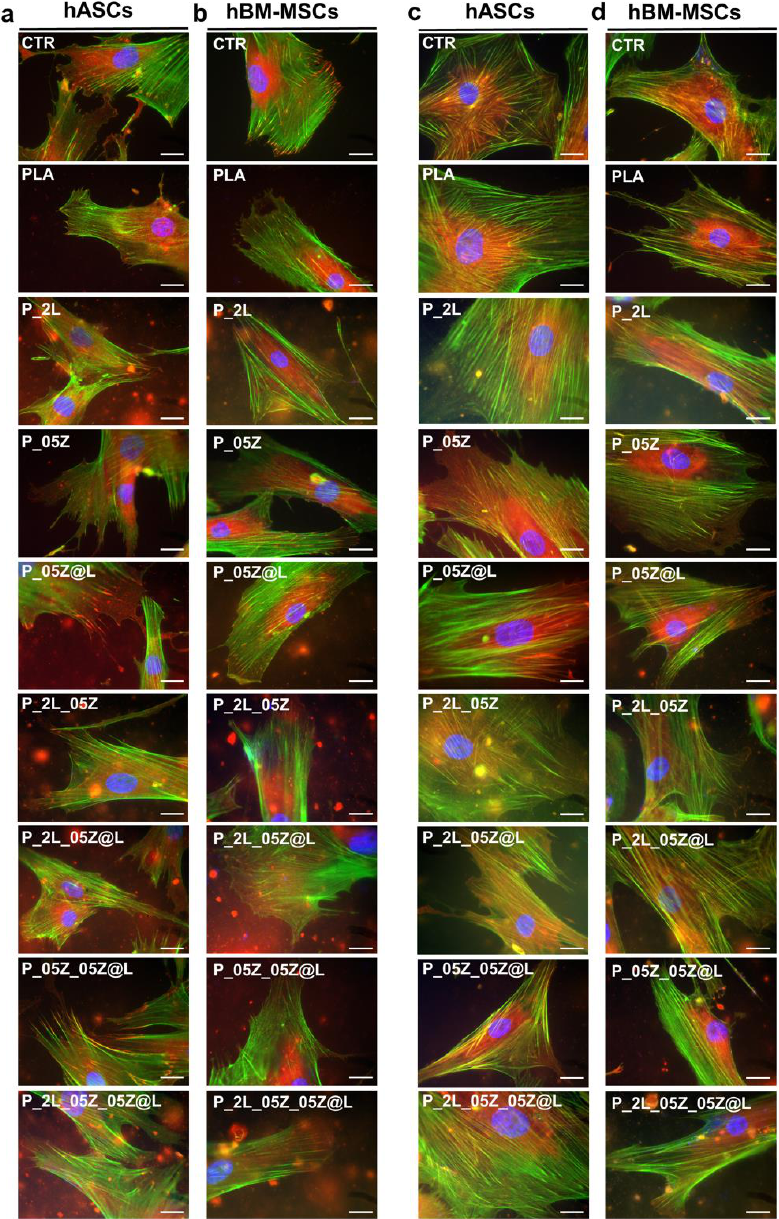
Figure 11. ( a , b ) Vinculin expression in hASCs ( a ) and hBM-MSCs ( b ) on PLA and PLA-binary, -ternary and -quaternary films. Representative images of Vinculin spots (anti-Vinculin antibody; RED) in CTR, PLA and PLA-based films. F-Actin (Alexa-fluor-488 Phalloidin, green), Nuclei (4 (cid:48) ,6-diamidino-2-phenylindole, DAPI, blue), Scale bar = 20 m. ( c , d ) Filamin A expression in hASCs ( c ) and hBM-MSCs ( d ) on PLA and PLA-binary, -ternary and -quaternary films. Representative images of Filamin A (anti-filamin antibody; RED) in CTR, PLA and PLA nanocomposites. F-Actin (Alexa-fluor-488 Phalloidin, green), Nuclei (4 (cid:48) ,6-diamidino-2-phenylindole, DAPI, blue), Scale bar = 20